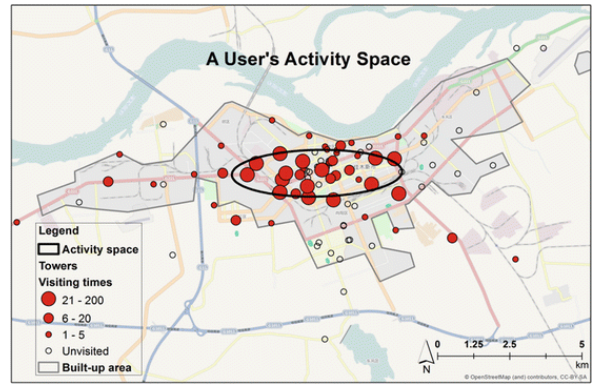
Figure 1. deviational ellipse (Wang, Kang et al. 2015) The approximation and measurement of activity space depict the basic characteristics of activity space (size, shape,